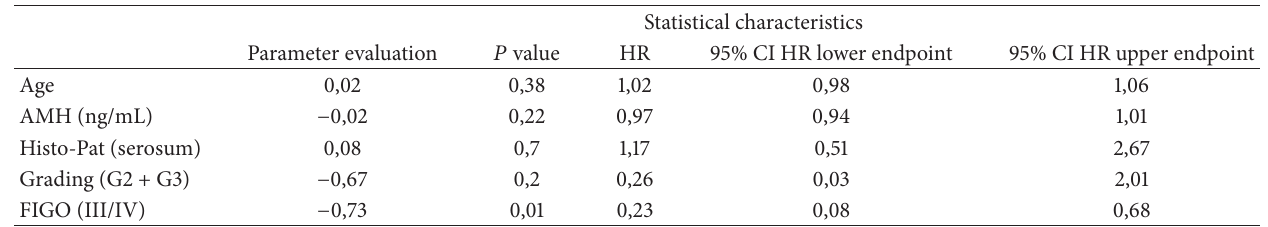
Table 6: Prognostic factors for overall survival selected by Cox’s multivariate